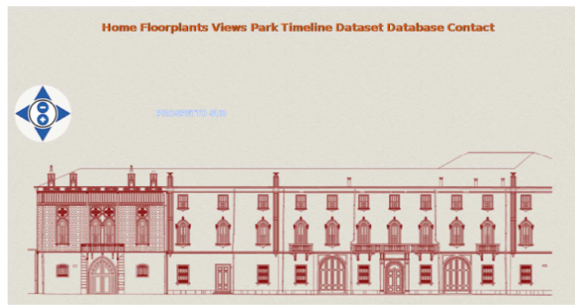
Figure 10. SVG view of Villa Revedin Bolasco.